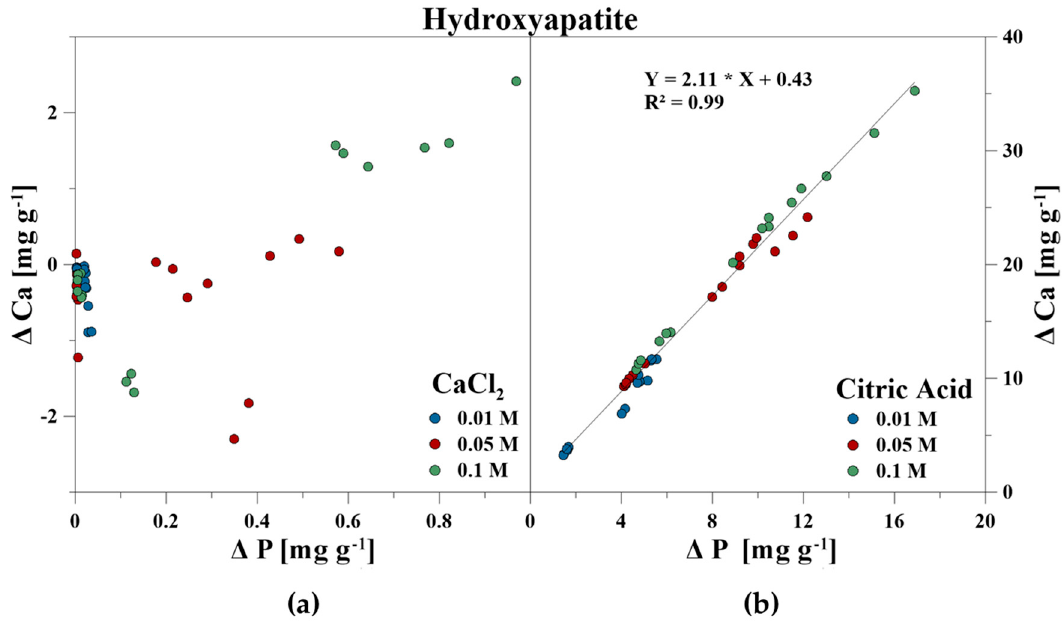
Figure 3. Correlation between dissolved P and Ca during P release using ( a ) CaCl 2 and ( b ) CA from hydroxyapatite.